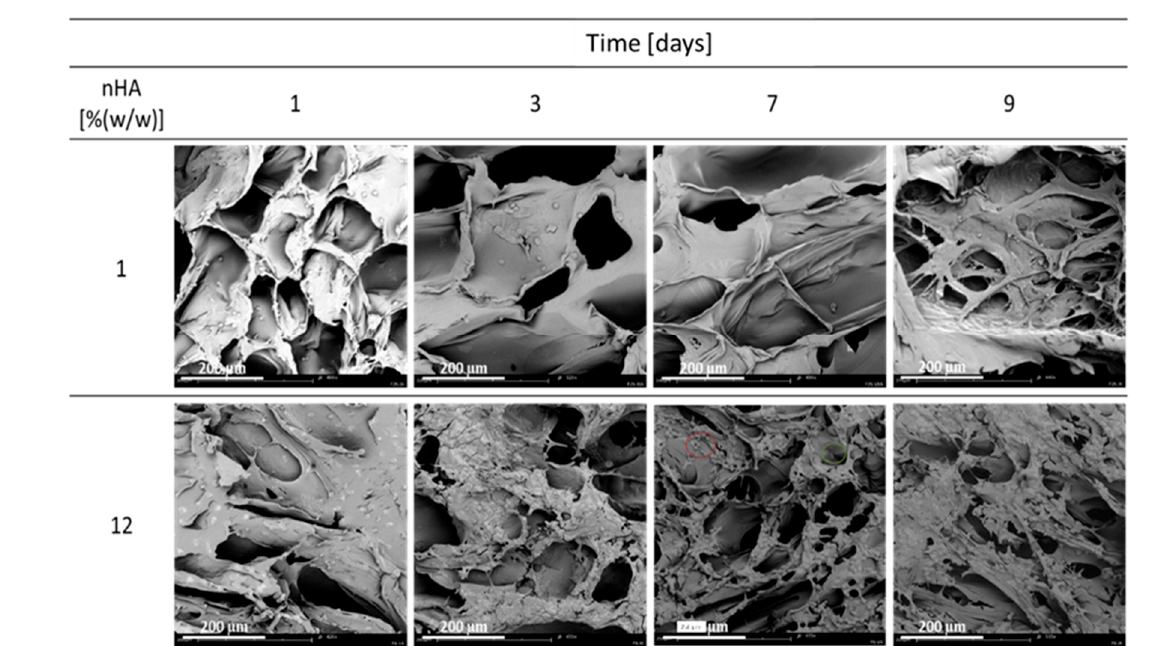
Figure 3. Cell culture on composite materials containing 1 and 12% ( w / w ) nHA produced at the conditions of T sat = 70 °C, P sat = 18 MPa, t sat = 1 h on 1, 3, 7 and 9